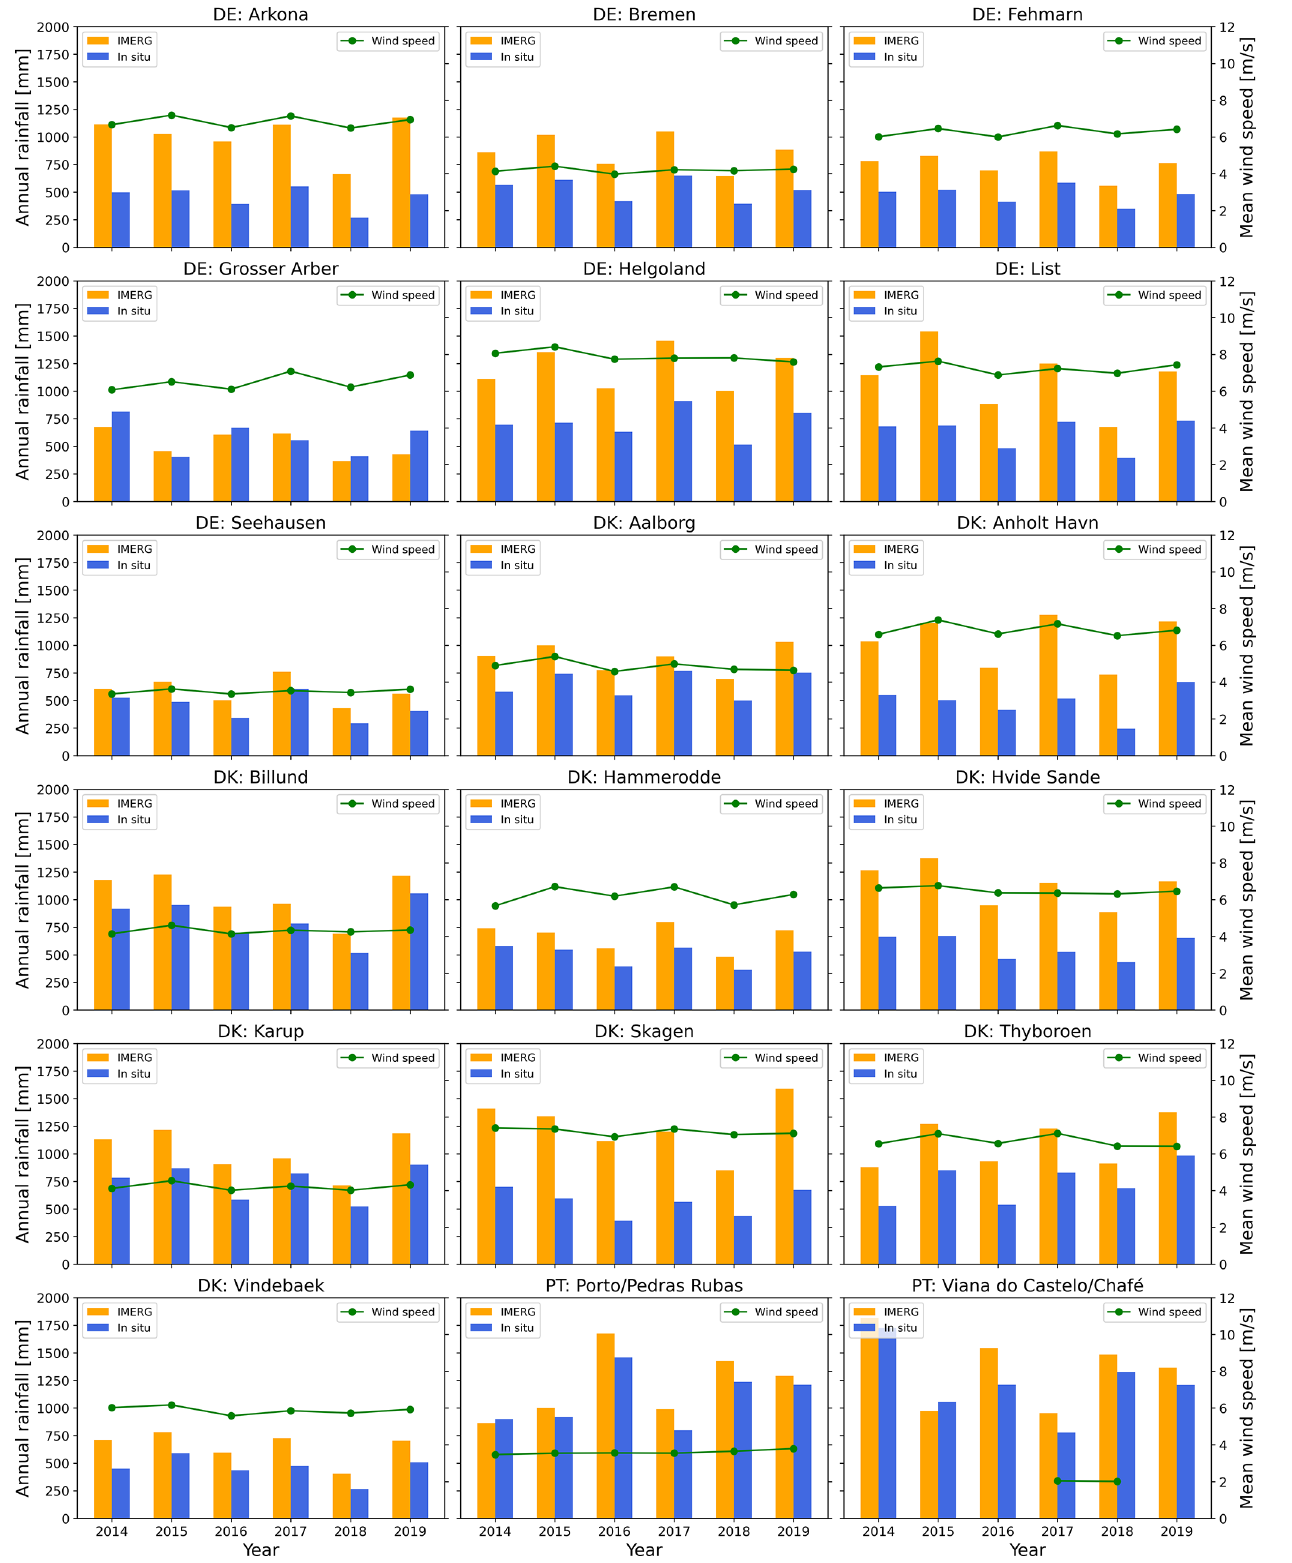
Figure 8. Annual rainfall from IMERG and in situ observations (bars) and annual mean wind speeds from in situ observations (green curves) during the period 2014–2019 for the 18 stations